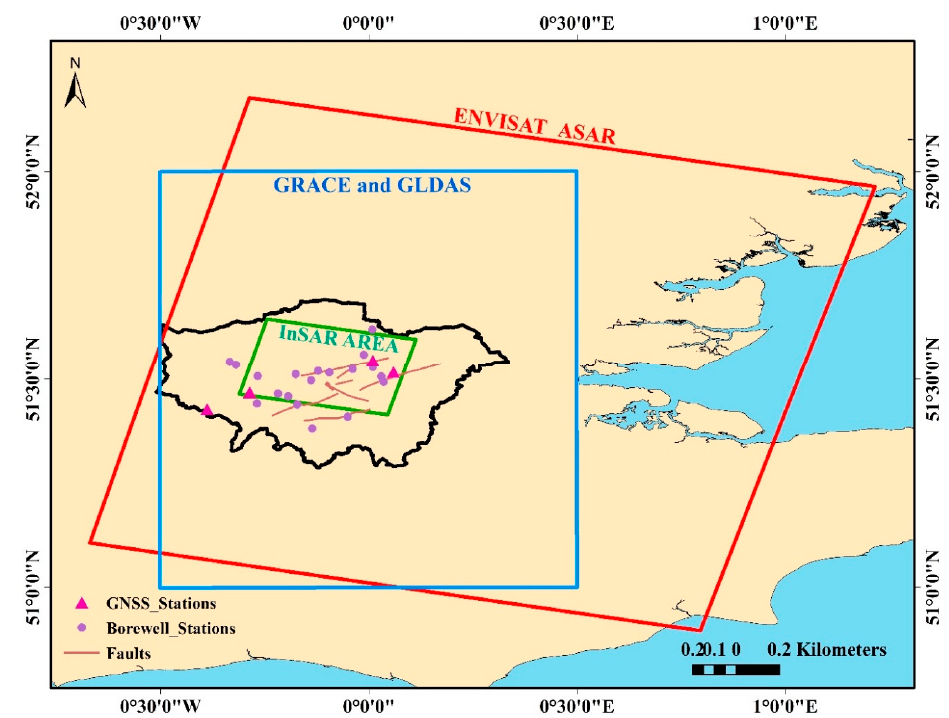
Figure 1. Study Area: Red box, blue box and green box show the extent of ENVISAT-ASAR (Environmental Satellite-Advanced Synthetic Aperture Radar) image, the extent of GRACE (Gravity Recovery and Climate Experiment) data used and InSAR (Interferometric Synthetic Aperture Radar) study area, respectively. Black boundary shows the administrative area of London. Purple dots, pink triangles and brown lines show the location of key boreholes, GNSS (Global Navigation Satellite System) stations and faults in the study area, respectively.